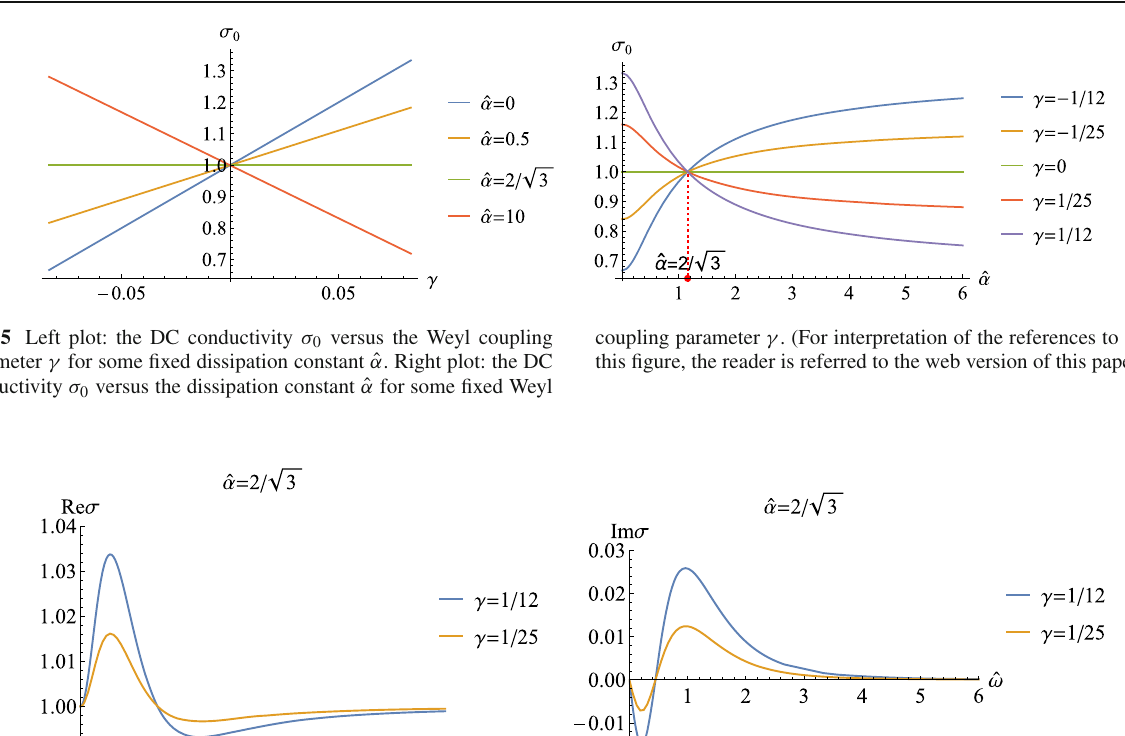
√ 3 and different values